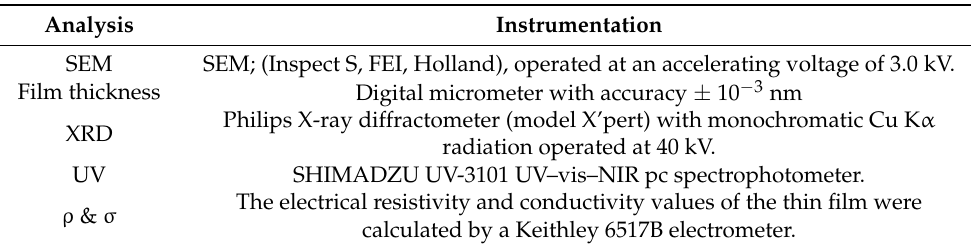
Table 1. Specifications of equipment used in